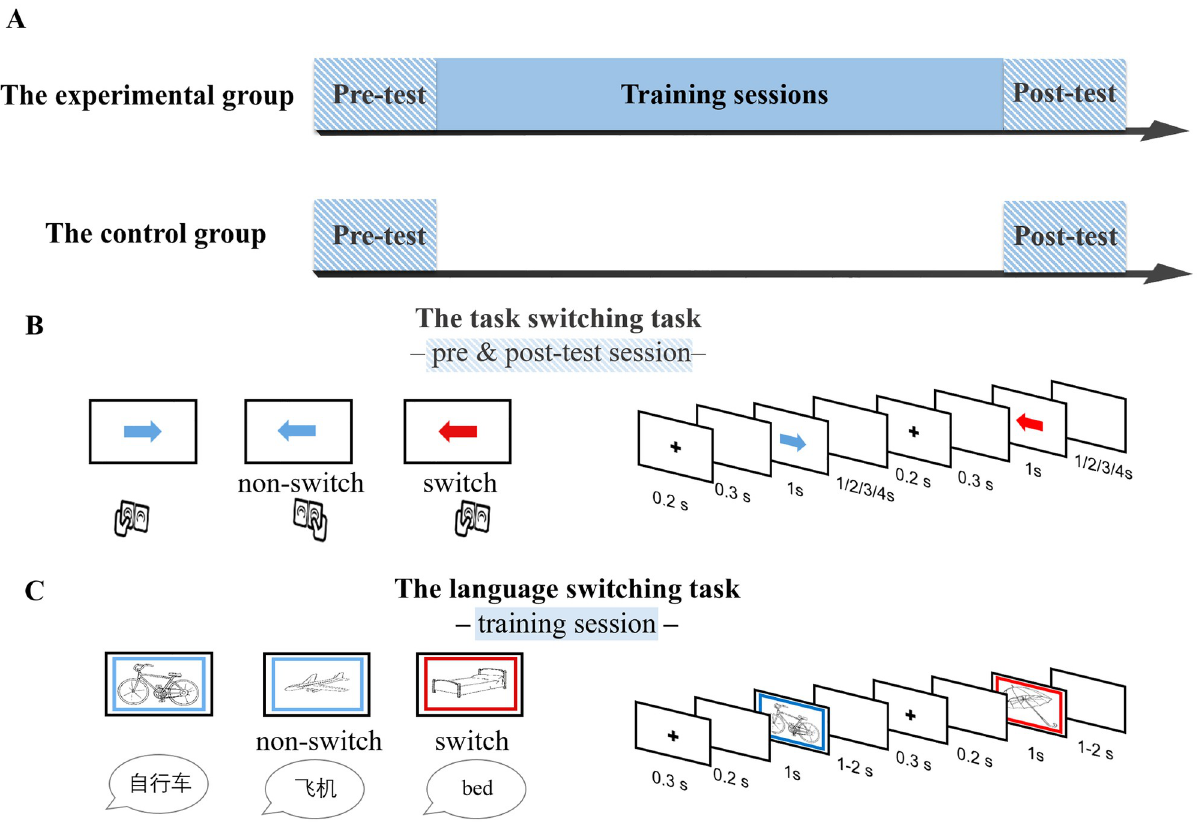
Fig 1. Schematic overview of the experimental design and task. ( A ) Two groups performed the same task switching task at the pre- and post-test fMRI sessions. During the training session, the experimental group received training on a language switching task, whereas the control group did not receive any training. ( B ) Illustration of the task switching task: press the key on the same or opposite side to which the arrow pointed according to the color of arrow. ( C ) Illustration of the language switching task: name the picture in either Chinese or English indicated by the color of the